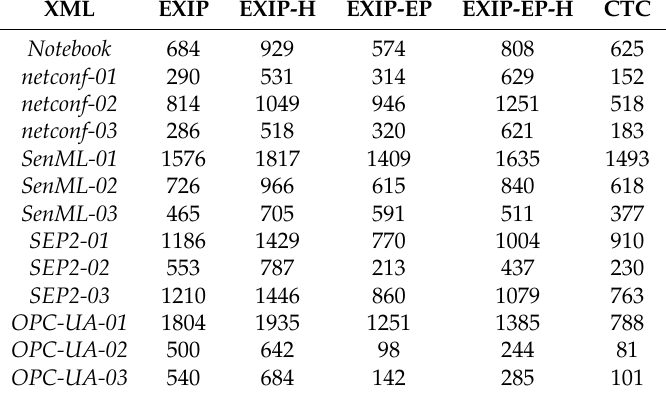
Table 4. XML document decoding time comparative. Numbers are in microseconds. EXIP : schema strict mode, all preserve options to F ALSE and schemaId to constant string “1”. EXIP-H : same options